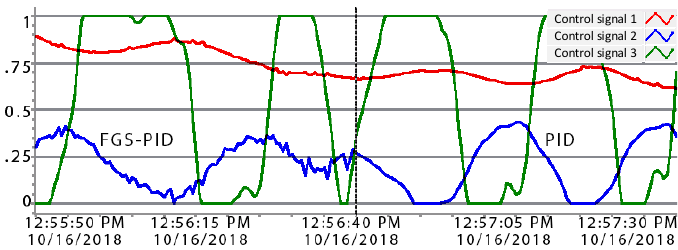
Figure 11. Control signal comparison for tank 2 when operating FGS-PID and PID control schemes.